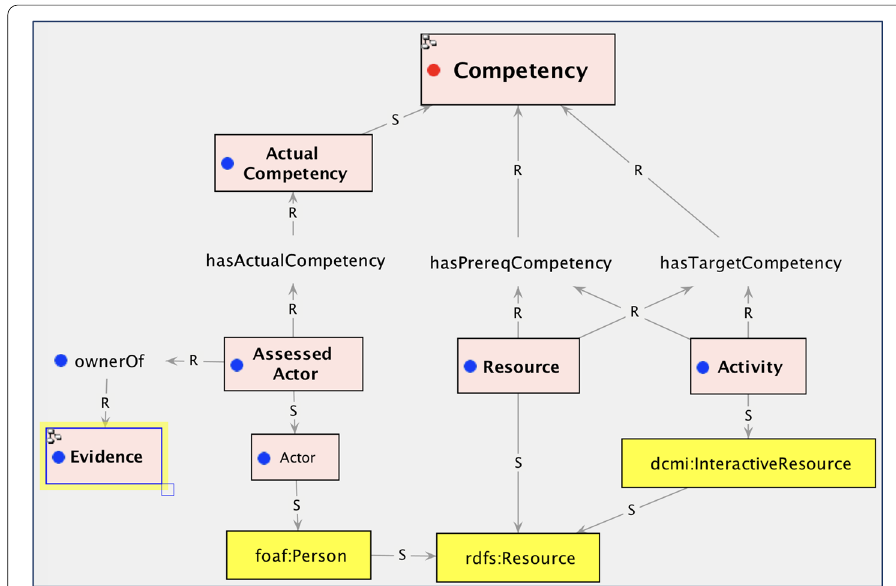
Fig. 5 Competency sub-model for referencing scenario